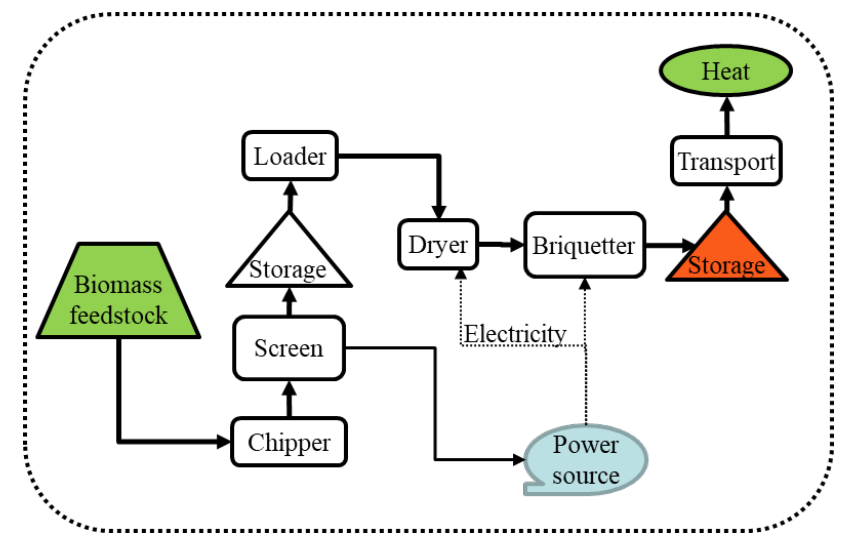
Figure 2. Forest landing to product 1—Process flow diagram of manufacturing of WBs at the near-wood site and delivered to customers in the city for heat generation.